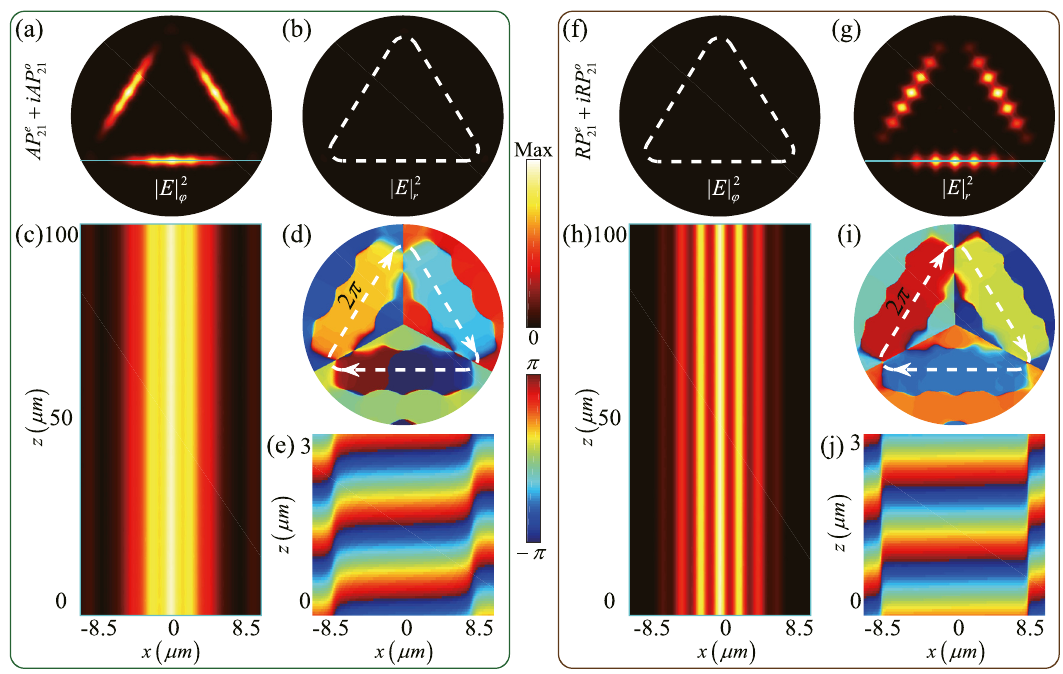
Figure 3: Azimuthally and radially polarized orbital angular momentum fiber modes. (a–e) Azimuthal electric field, radial electric field, propagating electric field, phase distribution, and propagating phase of APOAM + propagating electric field, phase distribution, and propagating phase of RPOAM + vertical sections for the propagating